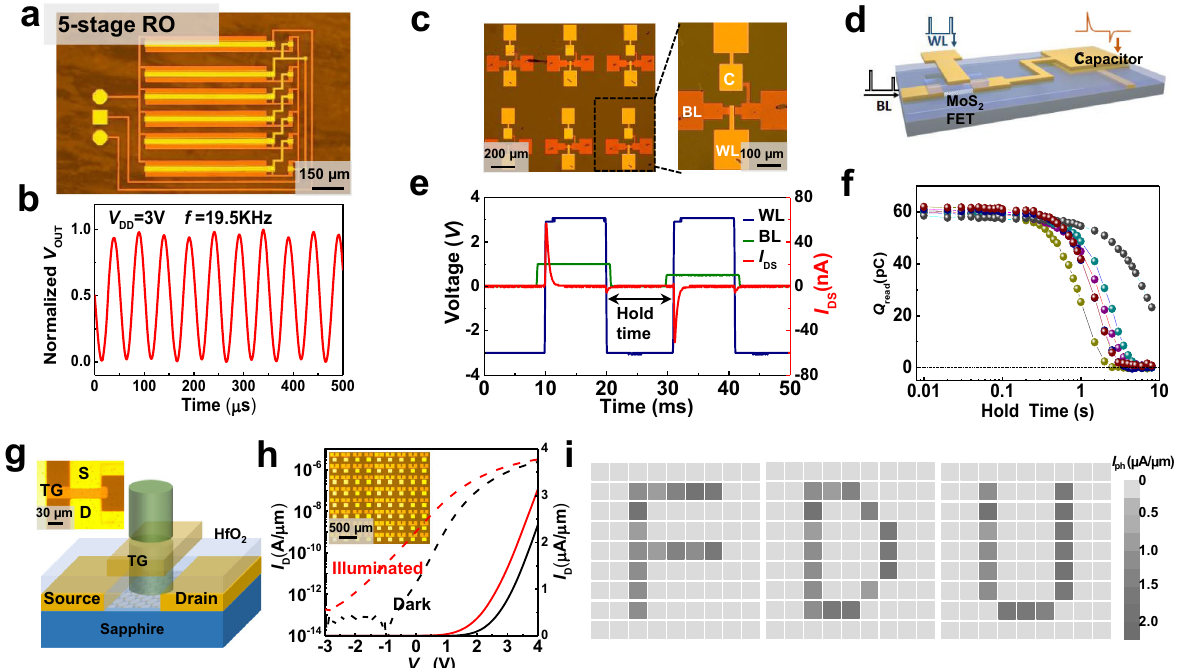
Fig. 4 Analog, memory, and optoelectronic circuits based on MoS 2 TG-FETs. a is an optical microscope image of a 5-stage ring oscillator, and b is the corresponding output characteristics at 19.5 kHz with V DD = 3 V. c Optical microscope image of MoS 2 memory-unit arrays. The right zoom-in shows the detailed structure of a 1T – 1C dynamic memory circuit, whose schematic diagram is shown in d . e , Write-and-read operations in the 1T – 1C unit. WL, BL, and I fi ve different devices. DS represent the write line, bit line, and working current. f Calculated charge stored in the capacitor as a function of holding time for g Schematic diagram of an MoS 2 phototransistor with a 10-nm-thick Au top gate, and h displays transfer characteristics with and without illumination at V = 0.5 V. The insets in g , h are the optical microscopic images of a MoS DS 2 phototransistor and its large-scale arrays, respectively. i Photocurrent mapping for a 9 × 9 MoS 2 FET array. The photocurrent is produced by scanning the array using a microscope-focused white